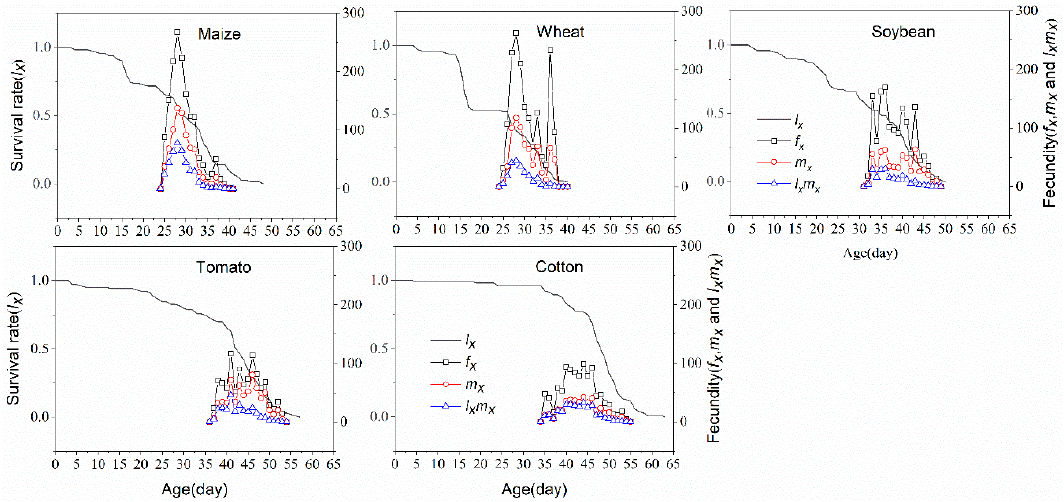
Figure 3. Age-specific survival rate ( l x ), female age-stage specific fecundities ( f x ), fecundity ( m x ) and net maternity ( l x m x ) of S. frugiperda fed on five plant species.